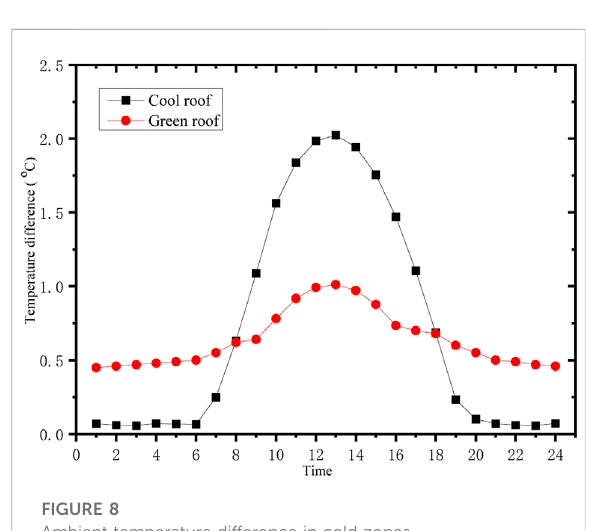
FIGURE 8 Ambient temperature difference in cold